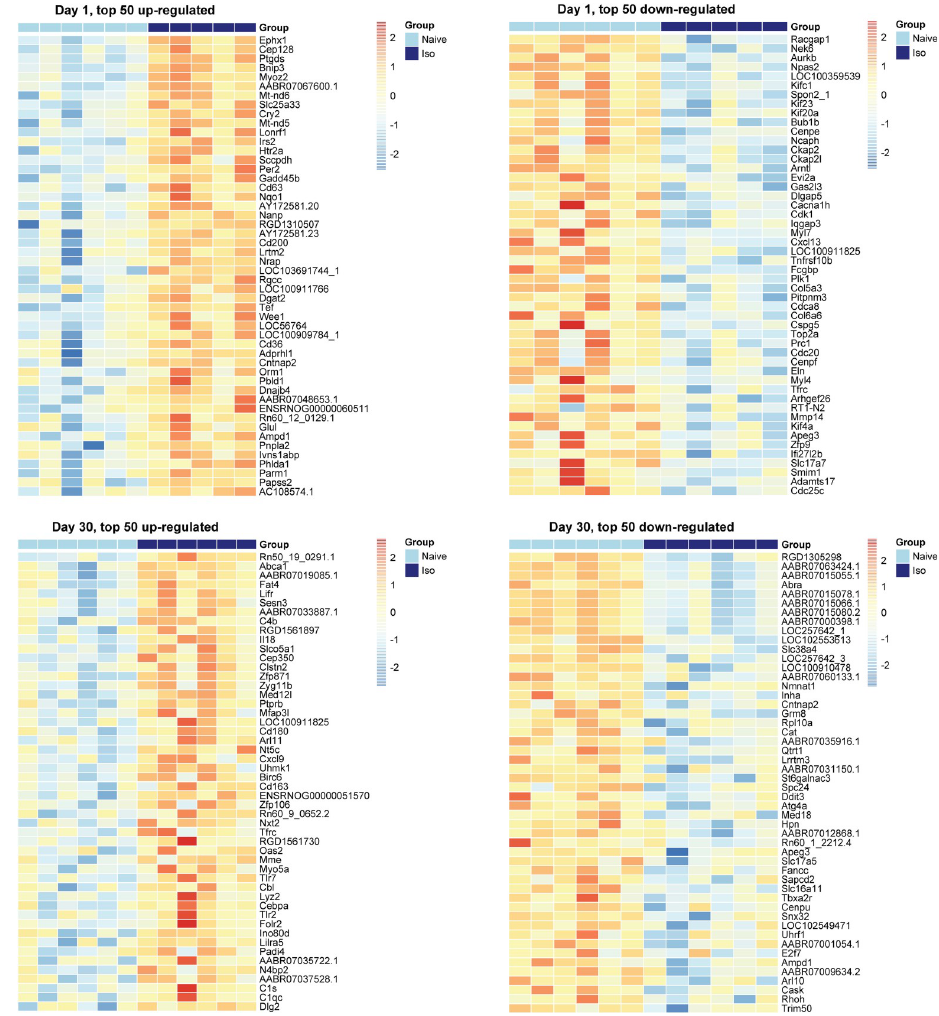
Fig 3. Heatmaps of top 50 up-regulated and down-regulated DEG at Days 1, and 30. In the group scale, the light blue stands for na ï ve samples and dark blue represents ISO samples. For each gene, expression values were standardized by the mean and standard deviation across samples. In the color scale, the red color means the expression value is above the average, while blue color means the expression value is below the average. Groups of rats exposed to air (na ï ve, n = 6 /Days 1 and 30 groups) or ISO (n = 5 /Day 1 group, and n = 6 /Day 30 group) were